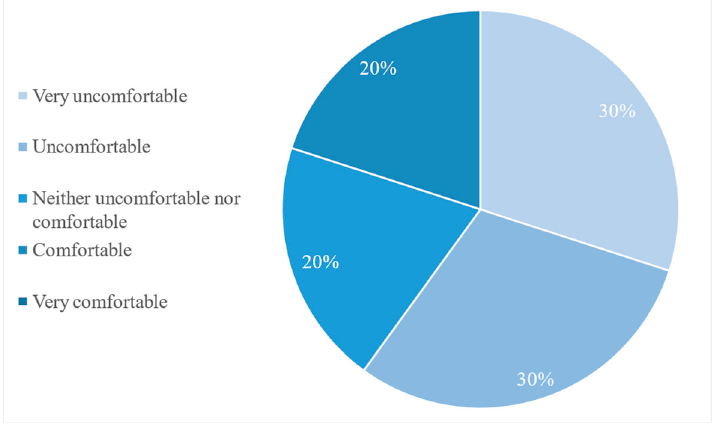
Figure 24. Answers to the question “How well did you understand where/how to place the compo- nents on the assembly?”.